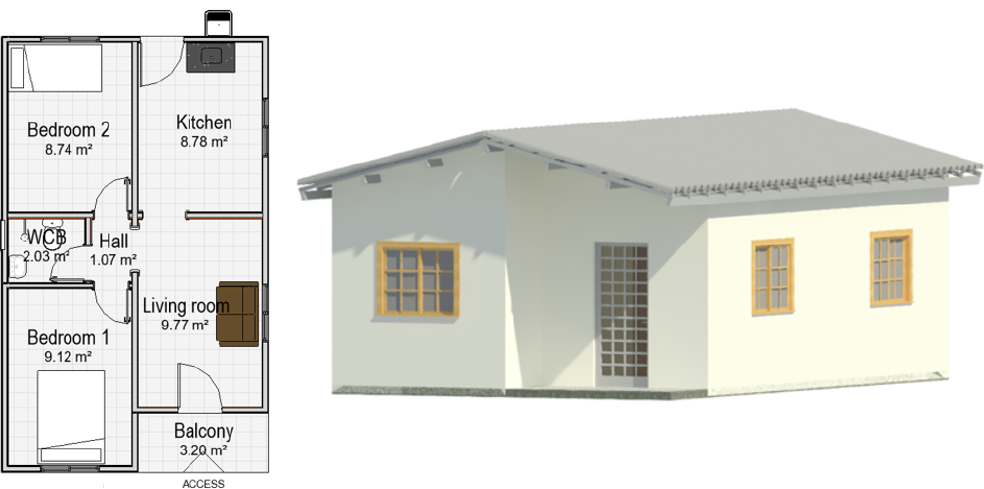
Figure 4. Floor plan and 3D view of the standard house. Table 1. Materials used.